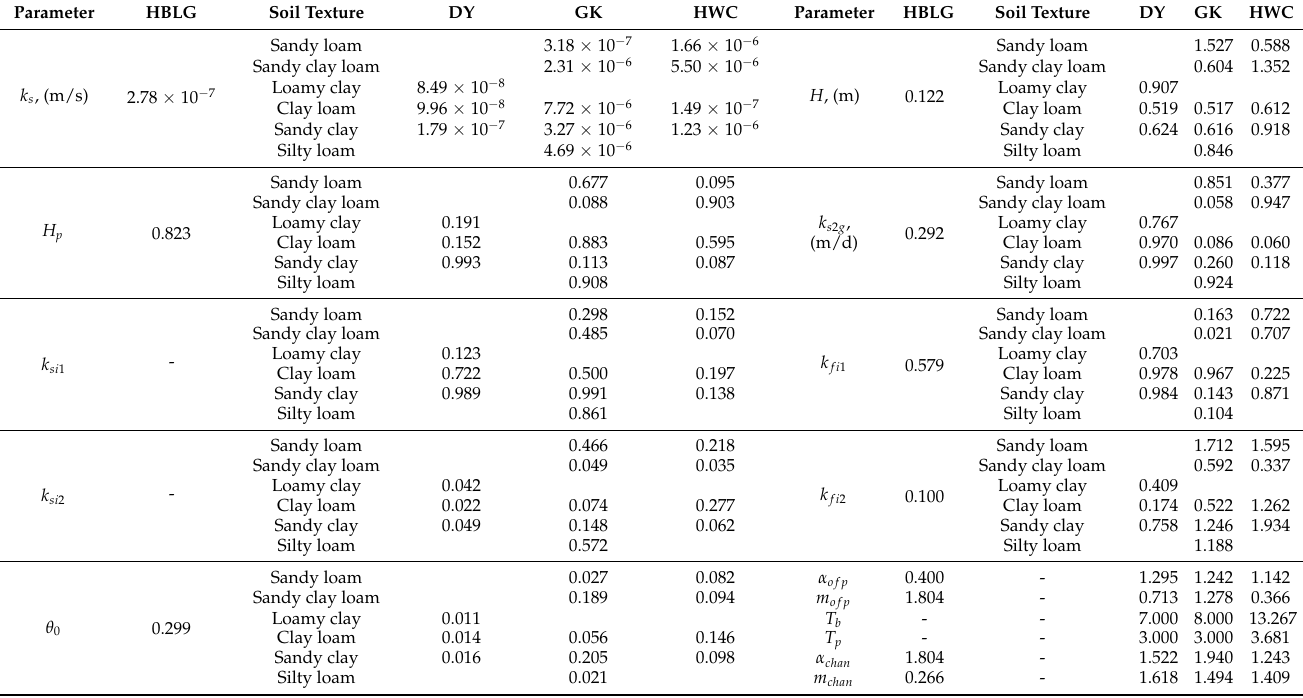
Table 6. Model parameters of Huangbengliugou (HBLG), Dayi (DY), Guankou (GK), and Hanwangchang (HWC).